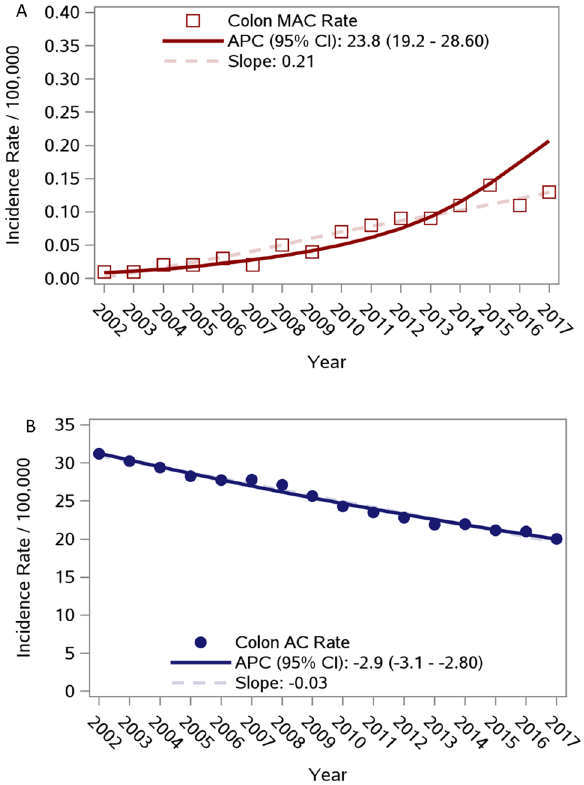
Figure 2. Colon medullary adenocarcinoma and adenocarcinoma incidence rates by histology. ( A ) Colon Medullary Adenocarcinoma. ( B ) Colon